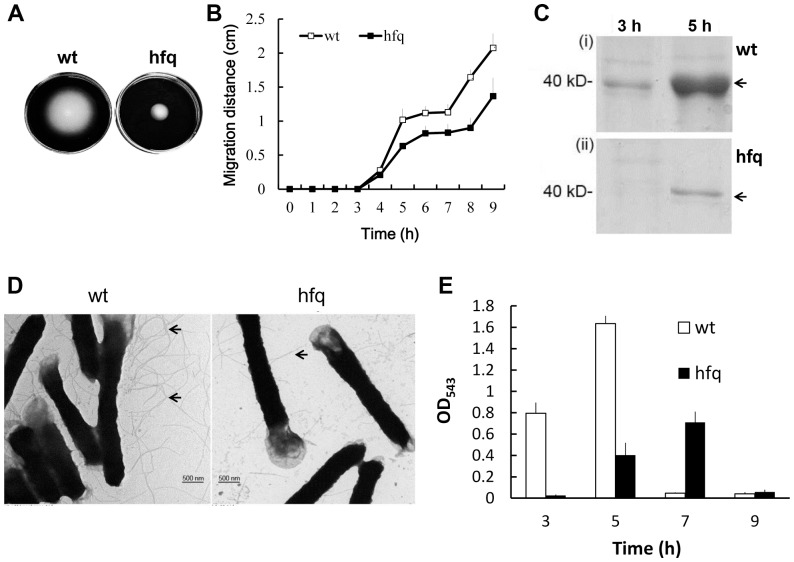

P. mirabilis hfq was required for motility and production of flagellin, flagella and hemolysin.(A) Swimming motility of the wild-type and hfq mutant. Aliquots (5 µl) of overnight culture were inoculated centrally into the LB swimming plates. The plates were incubated at 37°C. The representative picture was taken at 16 h after inoculation. (B) Swarming motility of the wild-type and hfq mutant. Aliquots (5 µl) of overnight culture were inoculated centrally onto the LB swarming plates. The plates were incubated at 37°C and the migration distance was measured hourly after inoculation. (C) The SDS-PAGE profile of flagellin of wild-type and hfq mutant at 3 h and 5 h after inoculation on swarming plates. The band of flagellin is indicated by an arrow. (D) TEM pictures of wild-type and hfq mutant cells. Bacterial cultures were applied onto a grid, cells were stained with 1% PTA and pictures were taken. Flagella are indicated by arrows. (E) Hemolysin activities of wild-type and hfq mutant during the swarming migration process. The representative result from three independent experiments is shown in A, C and D. In B and E, the data represent the average of three independent experiments with standard deviation. wt, wild-type; hfq, hfq mutant.